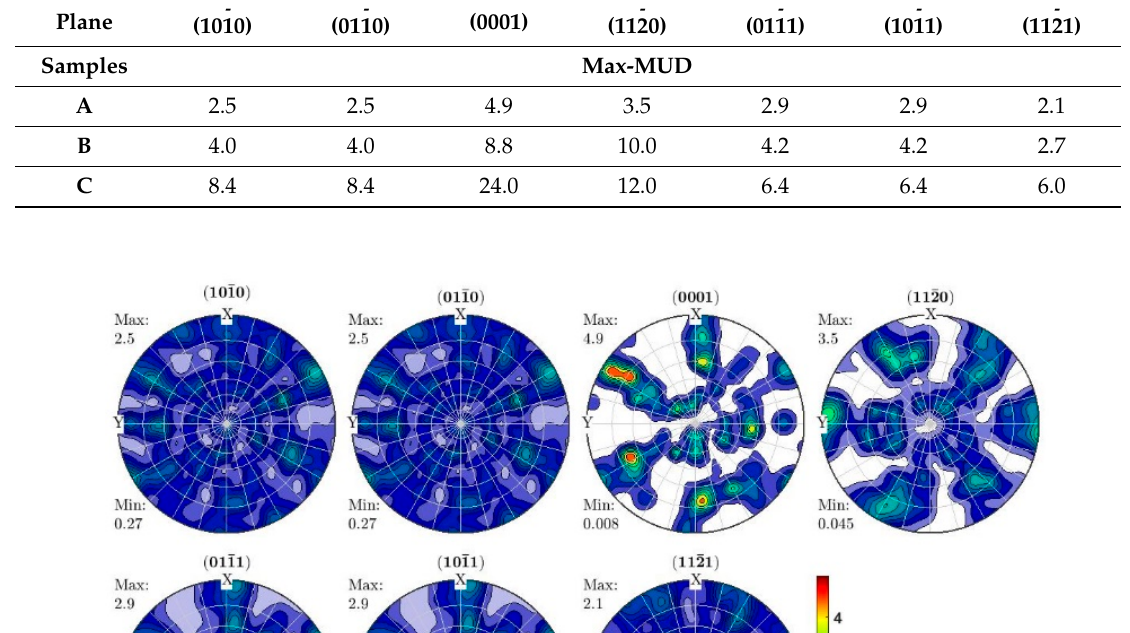
(cid:16) (cid:17) (cid:16) (cid:17) 1010 , 0110 , ( 0001 ) ,